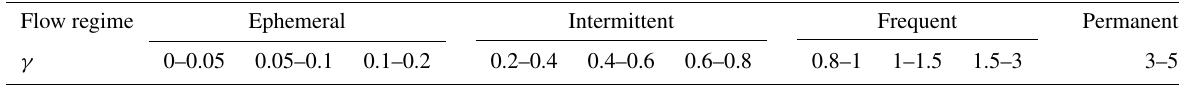
Table 2. Ten categories of river reaches based on γ values.